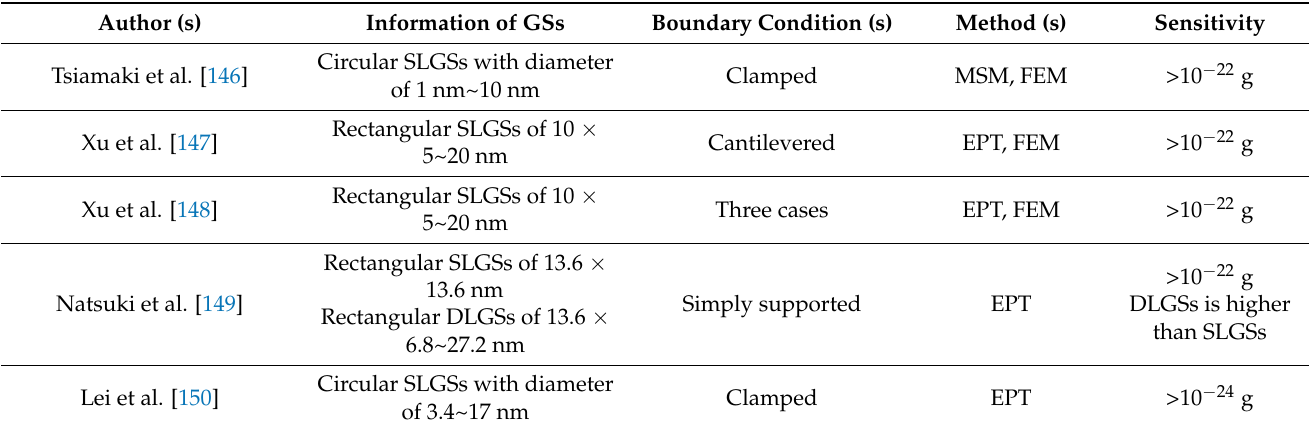
Table 2. Summarization of studies on graphene sheets-based nano-mass